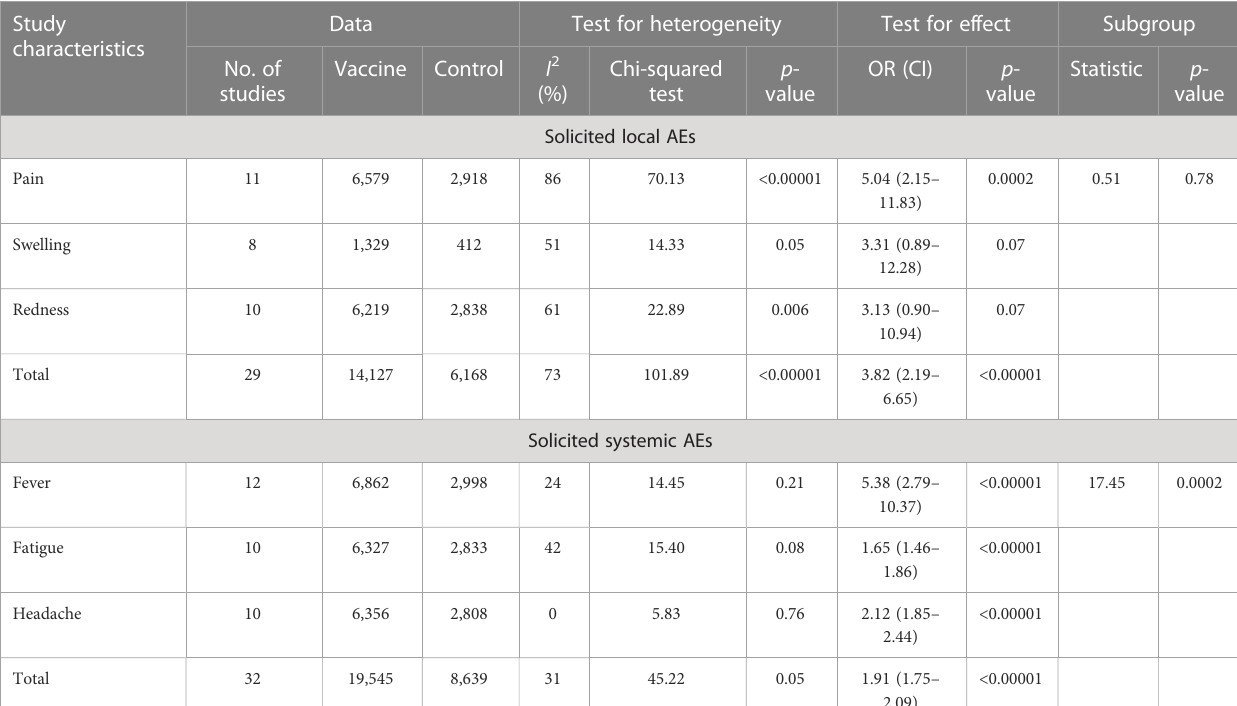
TABLE 4 Subgroup analysis for vaccine